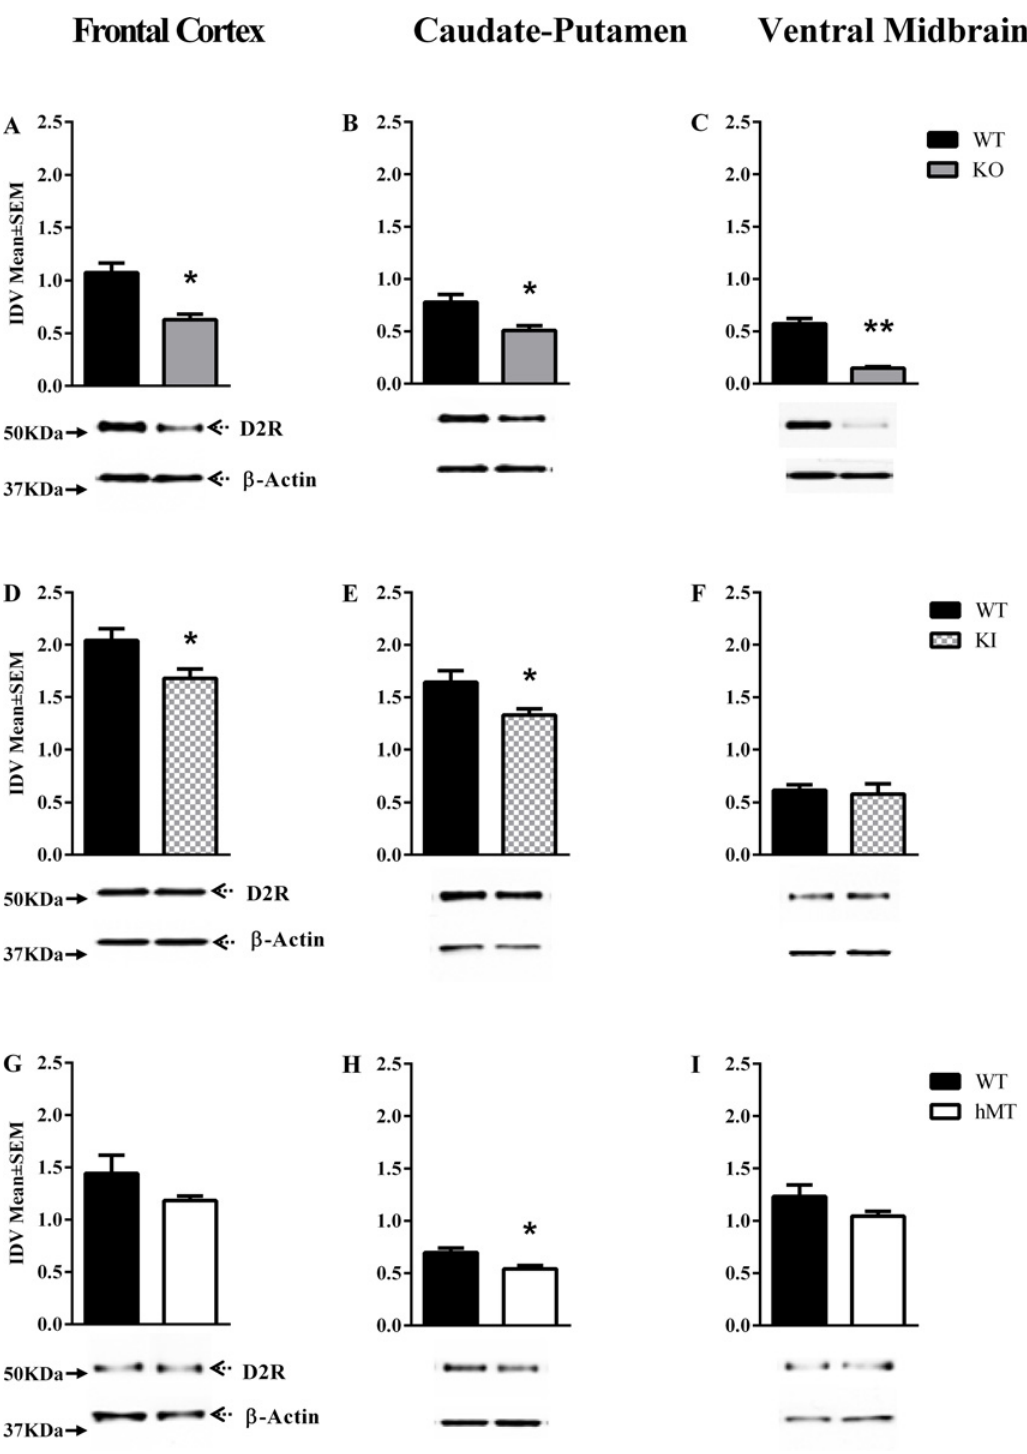
Fig 5. D2R expression at P60. D2R expression in the frontal cortex, caudate-putamen and ventral midbrain of postnatal day 60 (P60; A-I) mice. In each panel, the upper band shows D2R and the lower band shows β -actin, which was used as a loading control. The bar graphs in each panel represent D2R band intensity (mean ± SEM) normalized to intensity of loading control (integrated density value; IDV). The names of the mouse lines ( Dyt1 KO, Dyt1 KI, hMT) are indicated to the right ( * p < 0.05, ** p < 0.01; n = 3 or 4).